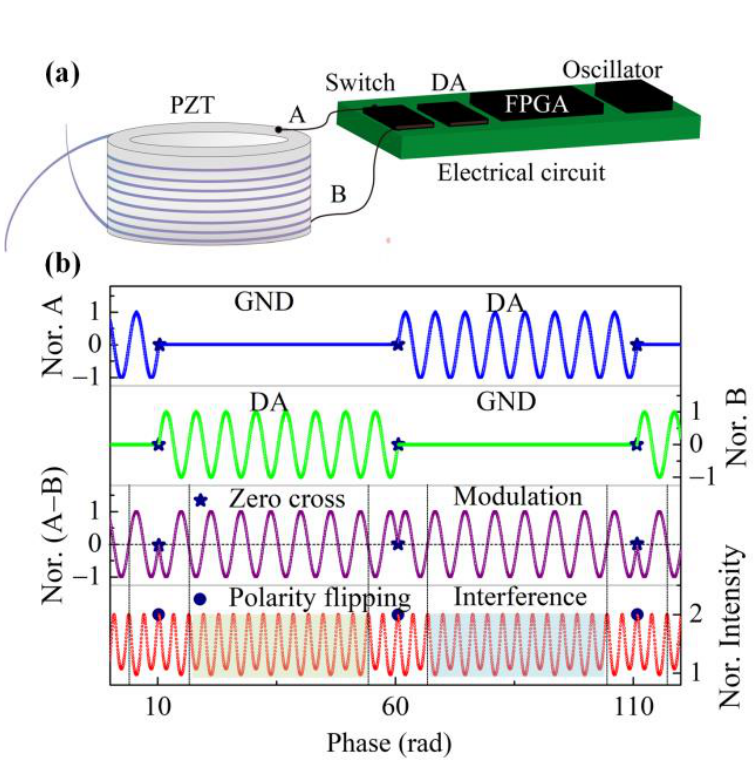
Figure 4. ( a ) Diagram of PZT control; ( b ) periodically flipped driving pattern, the modulation generated by the driving, and the corresponding interference signal of the gyro (assuming that the gyro has a Sagnac phase shift of 0.05 rad for clarity).